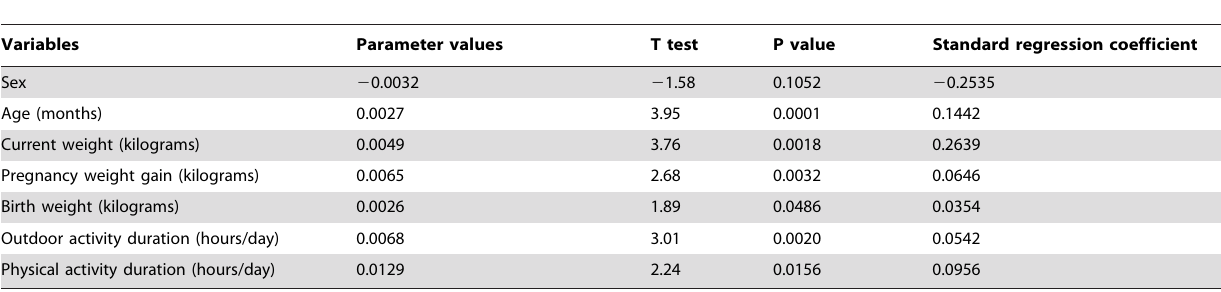
Table 6. Multiple linear regression analysis of influencing factors of BMD in healthy children